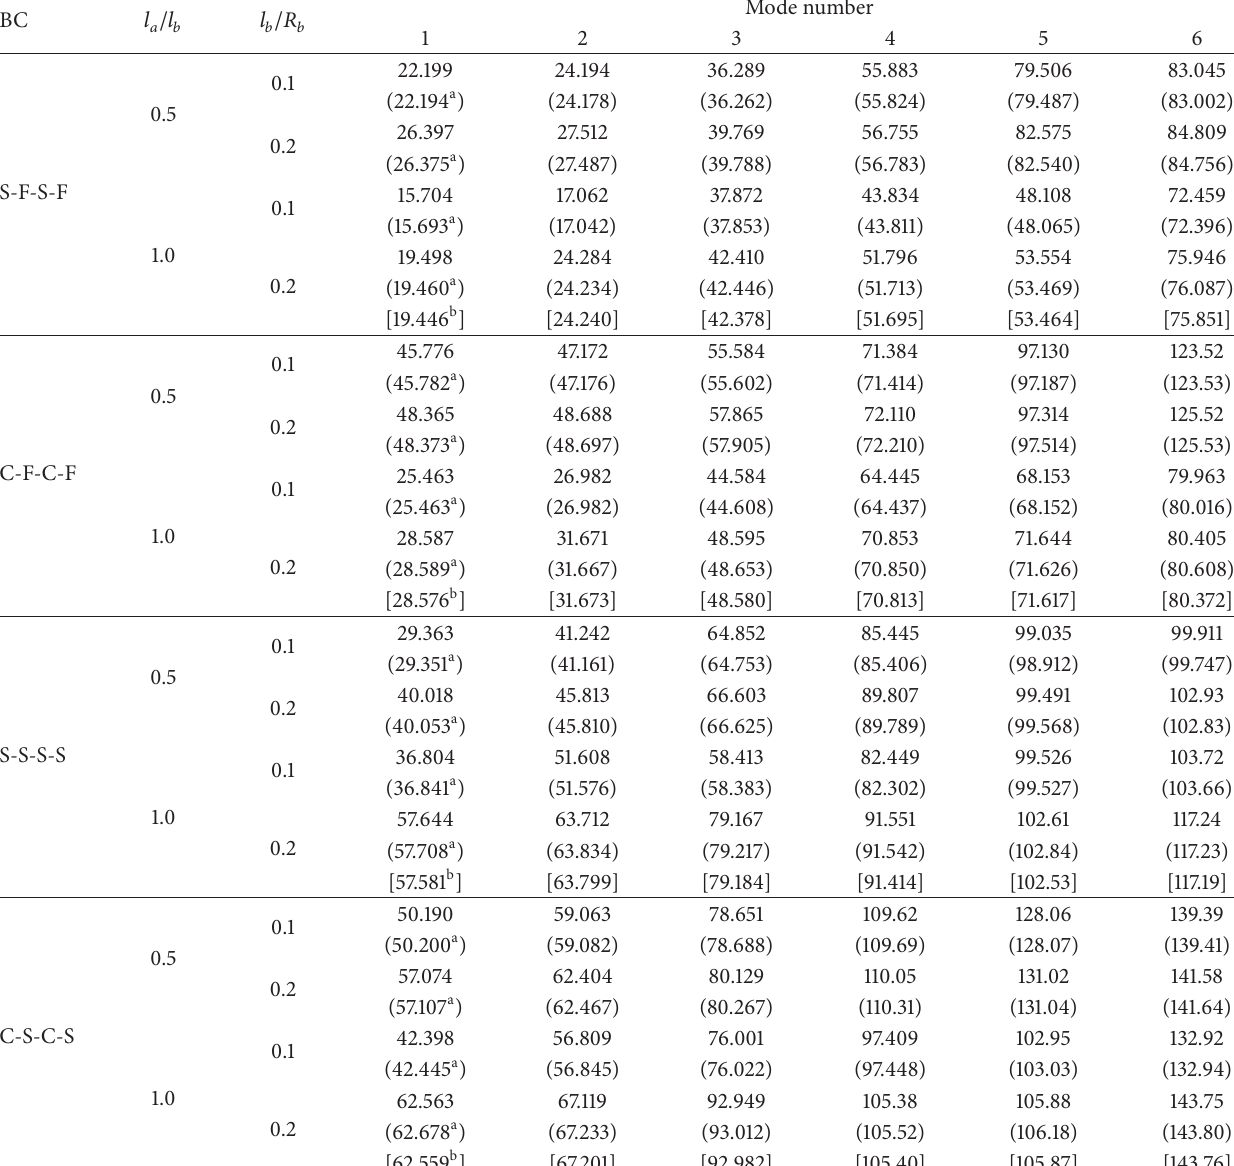
Table 4: Frequency parameters for different boundary condition singly curved shallow shells with thickness ratio ℎ/𝑙 𝑏 = 100 ( 𝜇 = 0.3 ).